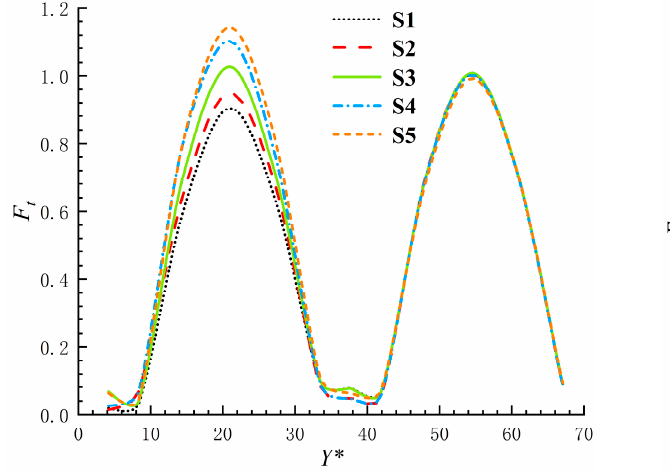
Figure 14. The normalized instantaneous streamwise velocity u* . ( a ) Section #04 in Case S1–S10; ( b ) and Section #07 in Case S1–S10.